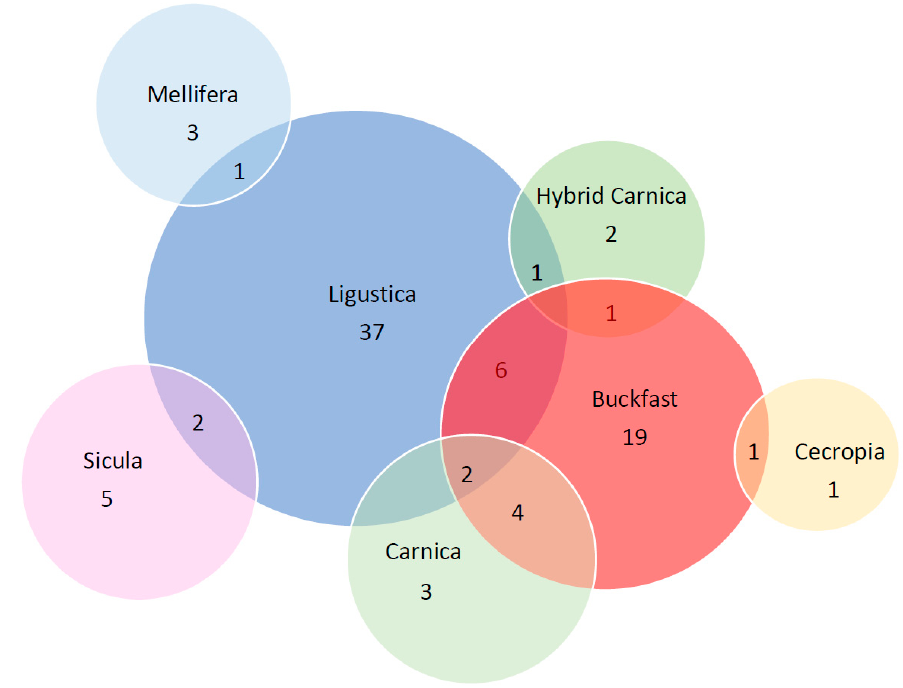
Figure 2. Venn diagram of the csd alleles among the 7 honeybee subspecies.